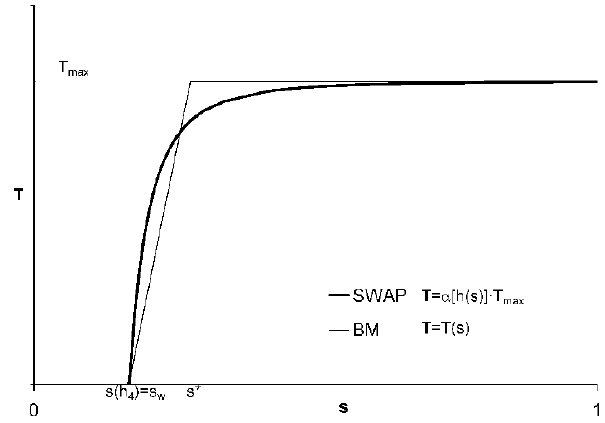
Fig. 3. BM transpiration function as compared with that of SWAP, after imposing the condition expressed by Eq.